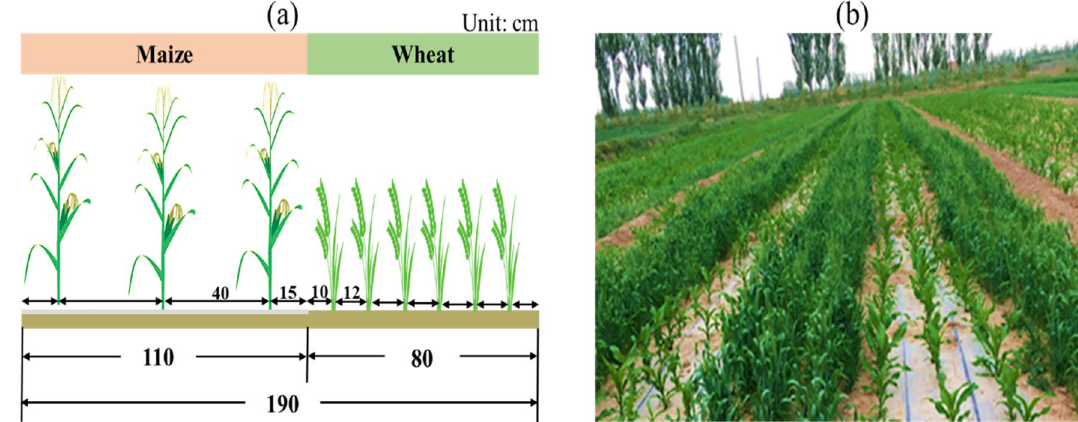
Figure 10. Information of ( a ) the spatial arrangement of wheat/maize intercropping with wheat strip of 80-cm (six rows) alternated with maize strip of 110-cm (three rows) and ( b ) the field planting diagrammatic representation of wheat/maize intercropping at Wuwei experimental station in northwestern